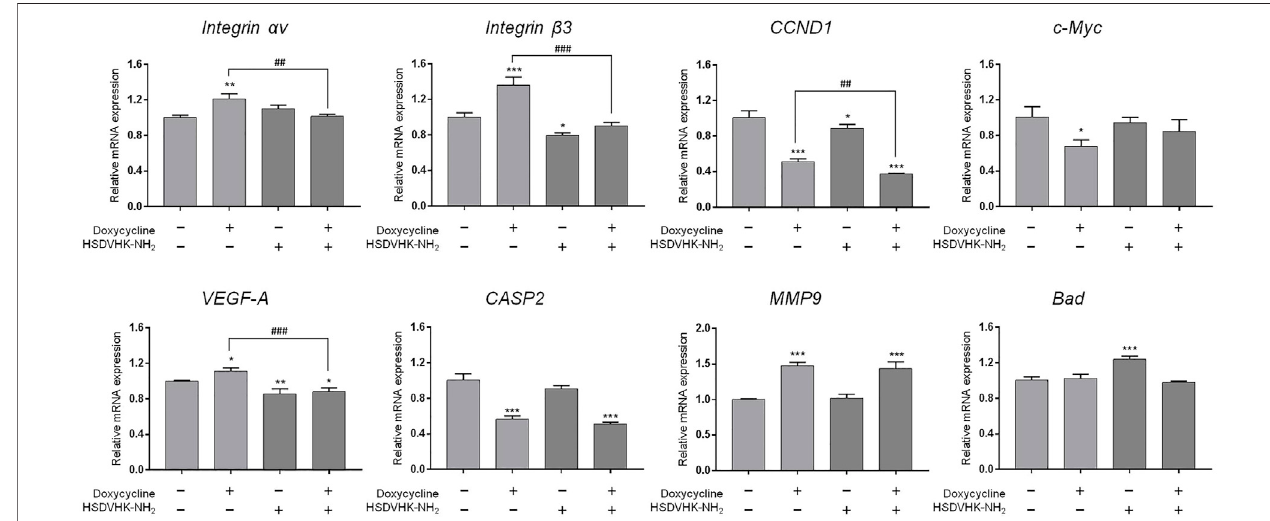
FIGURE 4 | Blockage of integrin α v β 3 activity inhibits doxycycline-induced gene expression in breast cancer MDA-MB-231 cells. MDA-MB-231 cells were pre- treated with HSDVHK-NH 2 (10 µM) for 24 h, then treated with doxycycline (60 µM) for 24 h. Cells were harvested. RNA was extracted for qPCR. Numbers of independent studies ( n ) = 3. ANOVA was used to assess statistical signi fi cance. * p < 0.05, ** p < 0.01, *** p < 0.001, compared to the untreated control. ## p < 0.01, ### p < 0.001, compared to doxycycline alone.